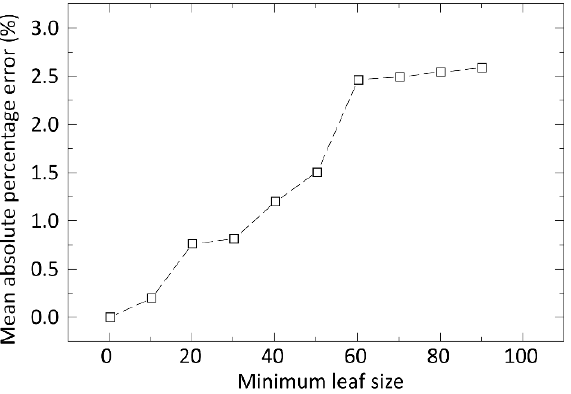
Figure 6. MAPE of prediction based on the parameter minimum leaf size.